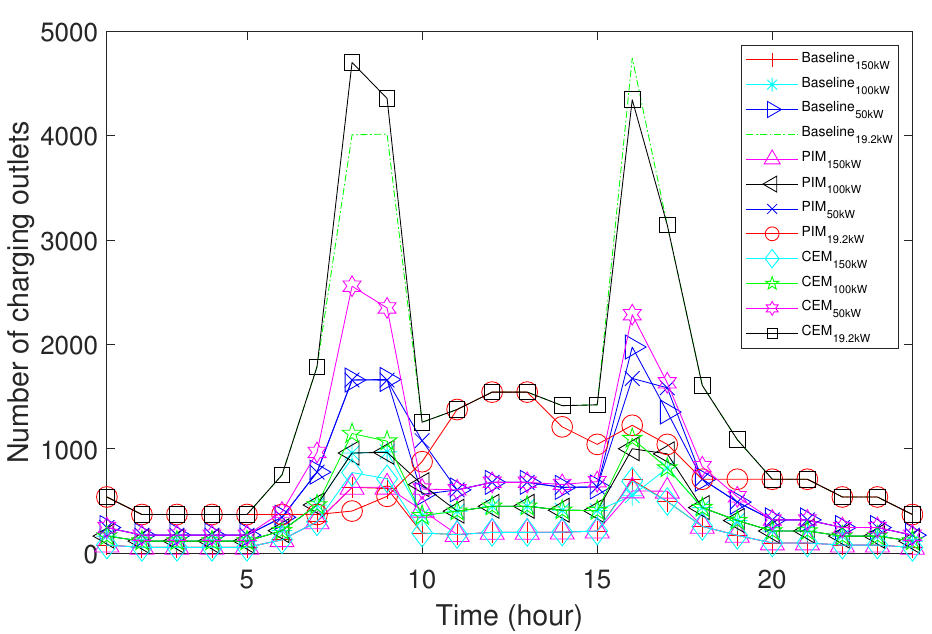
Figure 5. Comparison of charging demand.